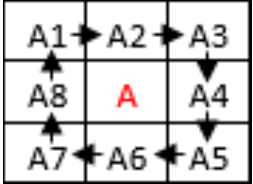
Figure 4. Spatial distribution of 8-neighborhood.